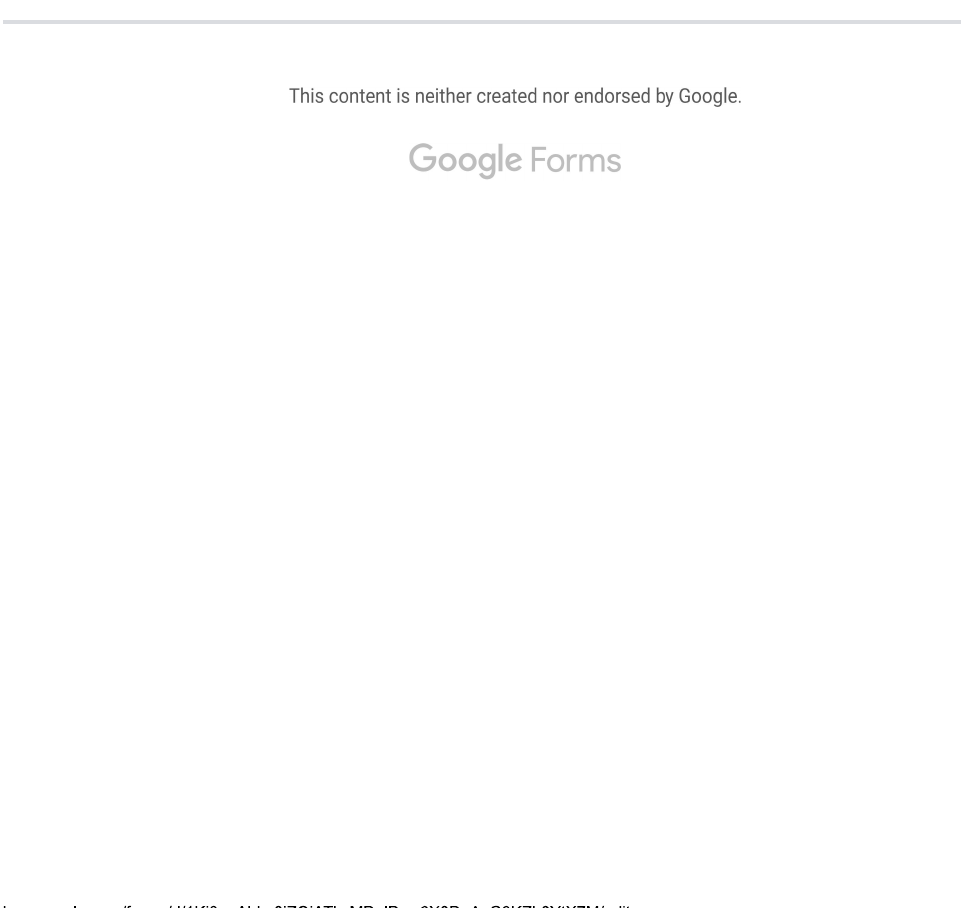
Figure A1. Portal vein thrombosis in bariatric